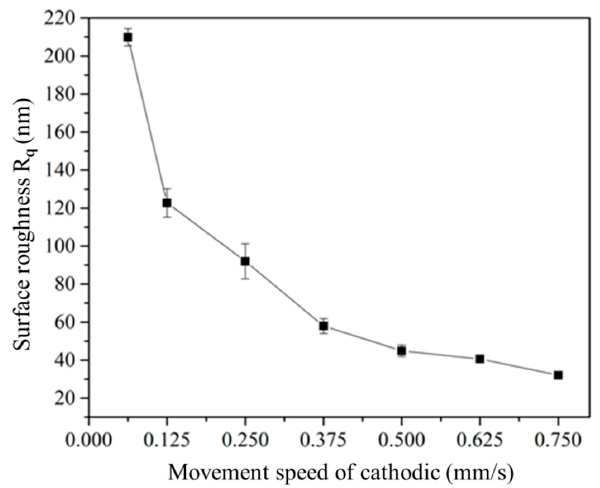
Figure 8. Surface roughness R q mean and standard deviation values for different cathodic specimen speeds when the electrode distance of 20 mm and the applied voltage of 220 V are fixed.